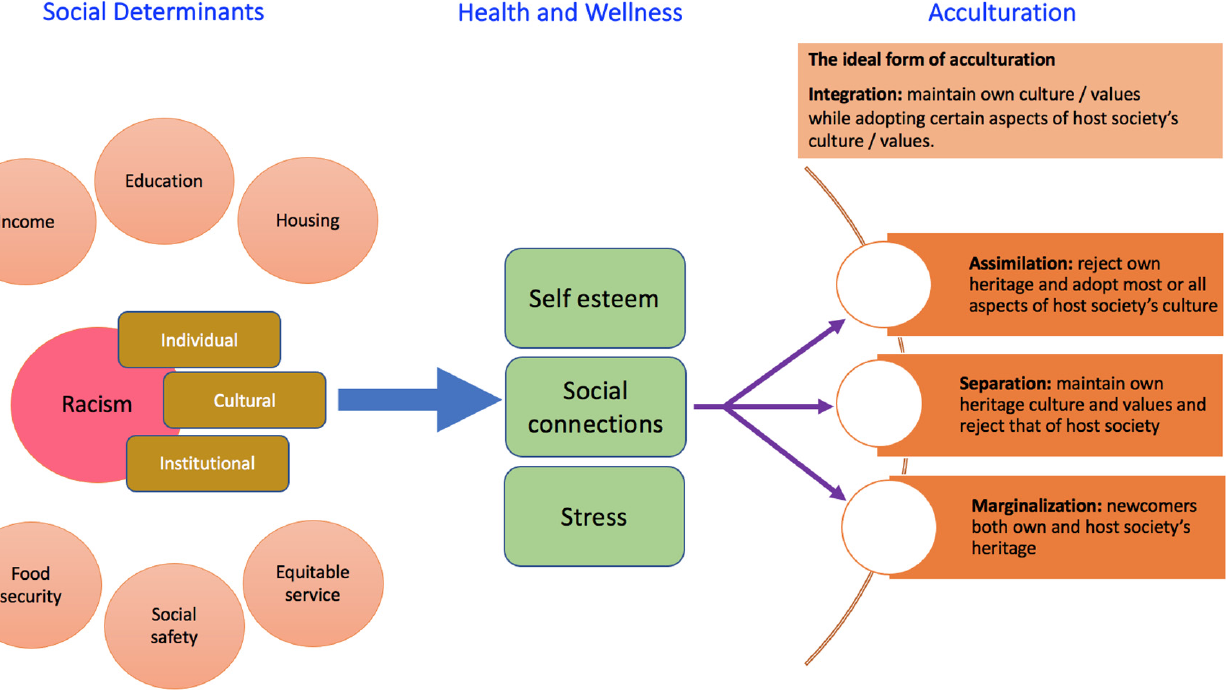
Figure 1. Racism as social determinant of health-wellness and acculturation of newcomers.